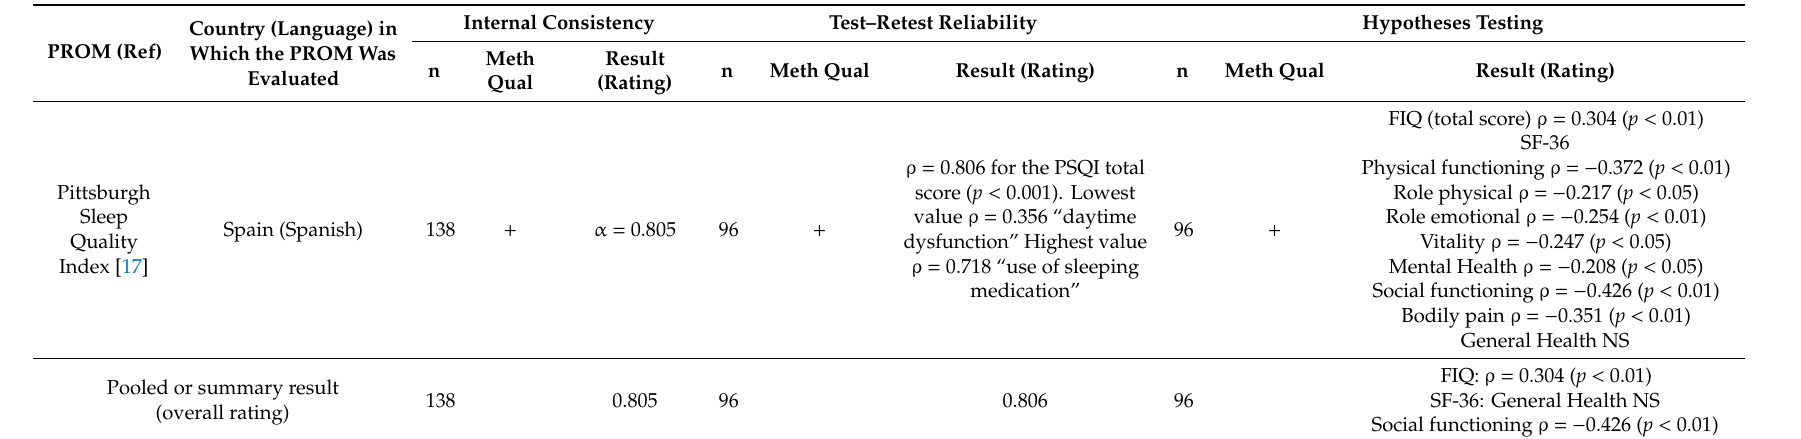
Table 5. Results of studies on measurement properties (PSQI).